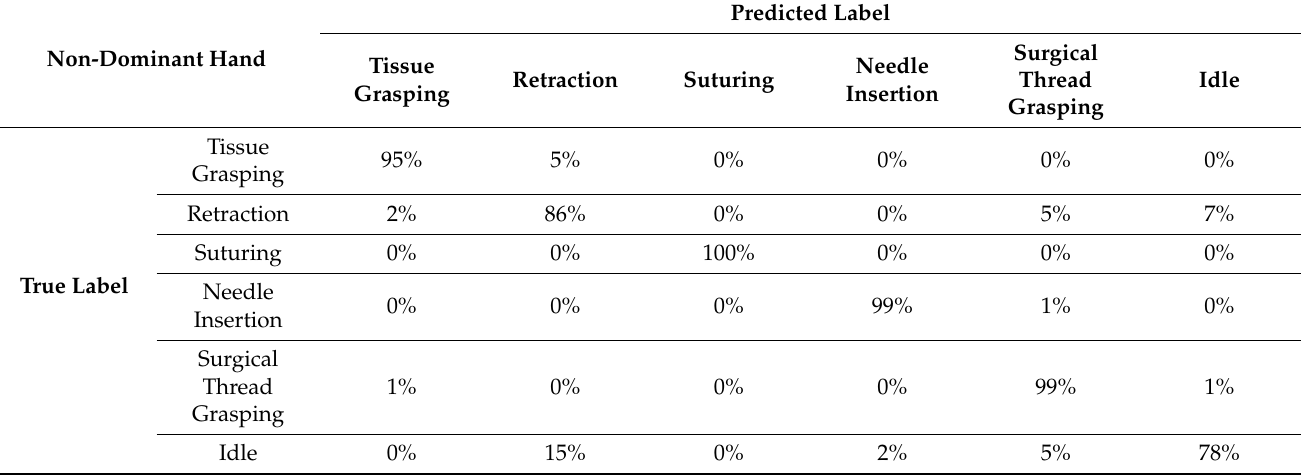
Table 7. Confusion matrix for classification of six surgical gestures performed by non-dominant hand. Non-Dominant Hand